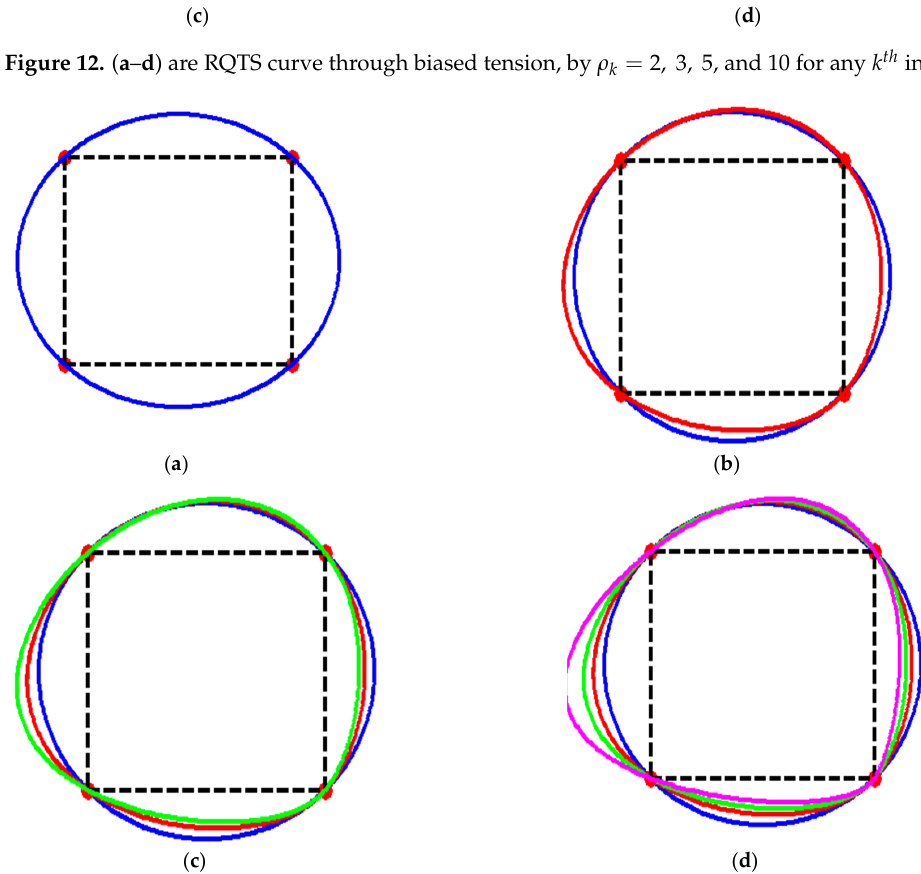
Figure 13. ( a – d ) are RQTS curve through biased tension, by 𝜎 (cid:3038) (cid:3404) 2,3,5 , and 10 for any k th inter ‐ val. Figure 9b–d demonstrate that rising values of shape constraints 𝜌 (cid:3038) (cid:3404) 𝜎 (cid:3038) (cid:3404) 3, 5 and 100, for the base interval to stretch the curve in the base interval and consequently re ‐ veal interval tension. Figure 10b–d illustrate the biased tension with the increasing value of 𝜌 (cid:3036) (cid:3404) 3, 5 and 10. Similarly biased global tension is shown in Figure 11b–d with the increasing values of 𝜎 (cid:3036) (cid:3404) 3, 5 and 10. Whereas biased interval tension is also demon ‐ strated in Figures 12b–d and 13b–d with the increasing values of 𝜌 (cid:3038) (cid:3404) 3, 5 and 10, and (cid:3404) 3, 5 and 10, respectively, for any interval 𝑘 . 𝜎 (cid:3038) In Figure 14(a1,b1) default shape of objects is shown using RQTS whereas Figure 14(a2,b2) demonstrates the RQTS with local tension, using 𝜌 (cid:3036) (cid:3404) 𝜎 (cid:3036) (cid:3404) 100 at the man ‐ datory portion of the shapes. Remark 3. It is worthy of note that the suggested RQTS allows for both local and global modifi ‐ cations in the geometry of the objects. ( a1 )